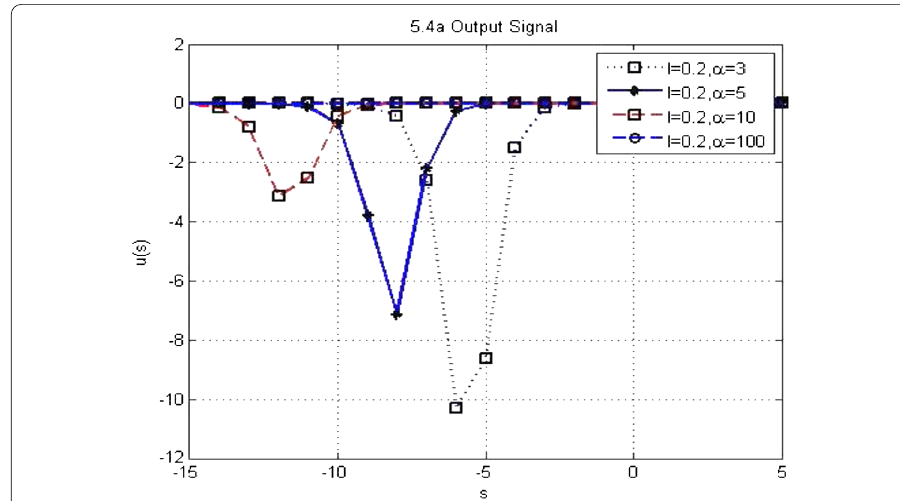
Figure 6 Output signal for (cid:5) = 0.2 and α